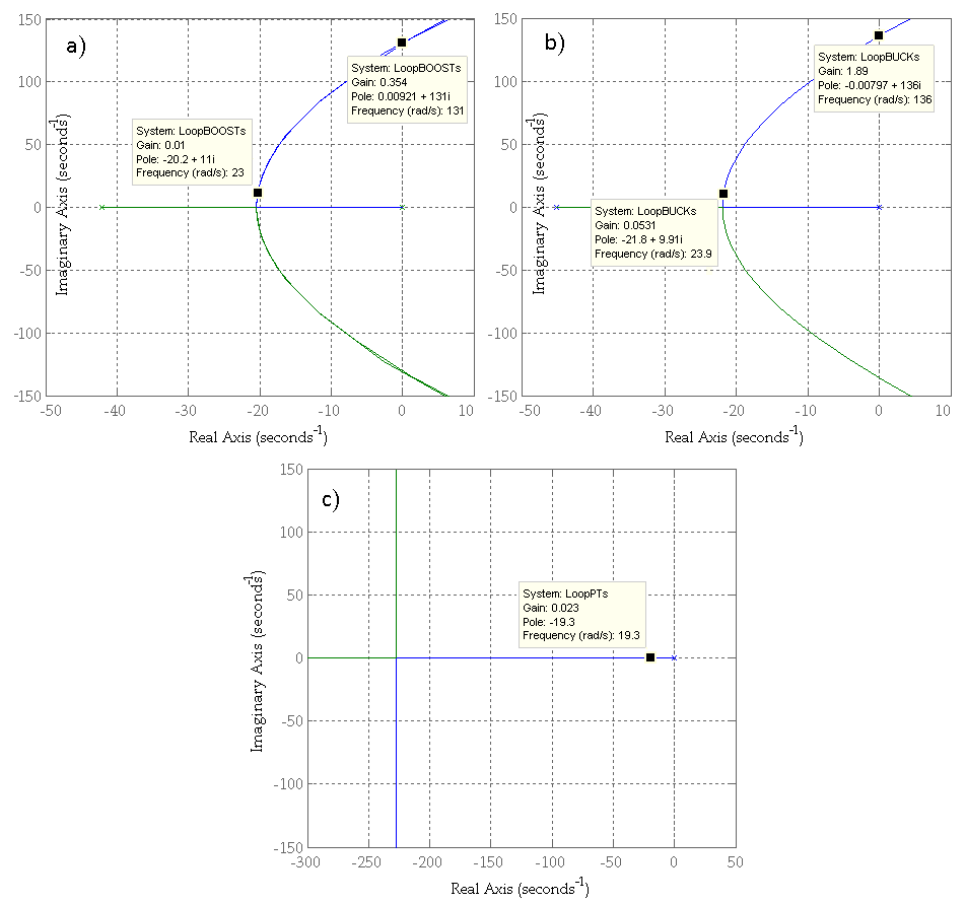
Figure 9. Root loci for interlinking converter (ILC) operation modes: ( a ) boost mode, ( b ) buck mode, and ( c ) power transfer mode.